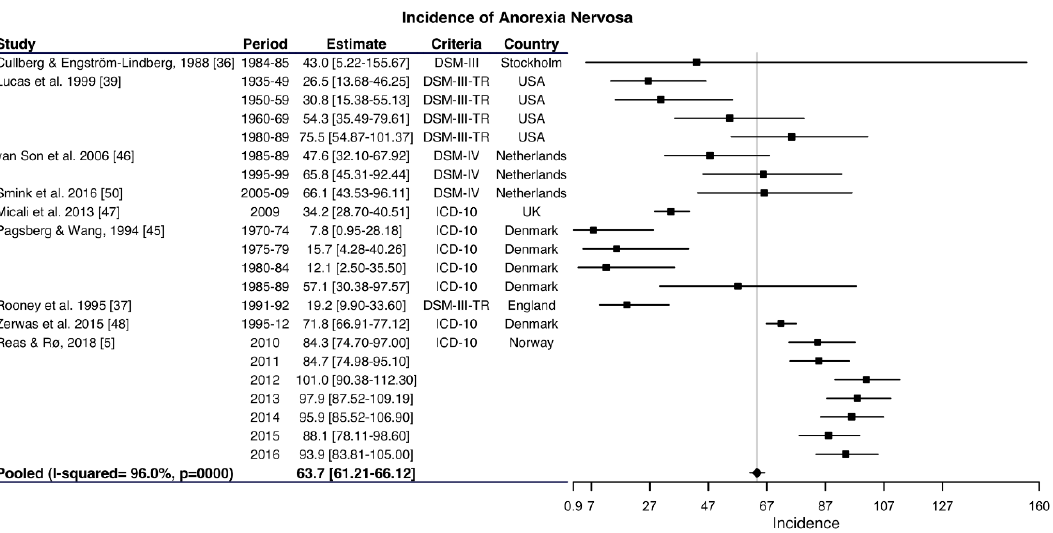
Figure 5. Forest plot of the meta-analysis of anorexia nervosa incidence rates in young women in outpatient healthcare services.